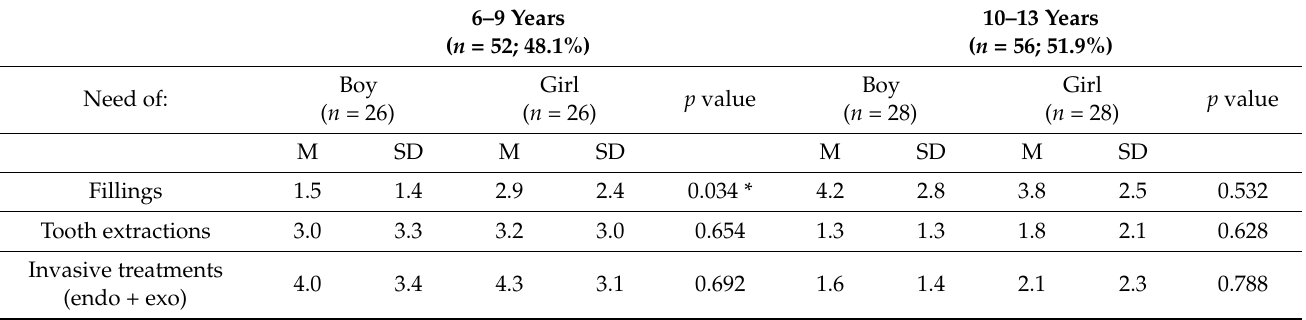
Table 6. Comparison of dental treatment needs by sex in different age groups.